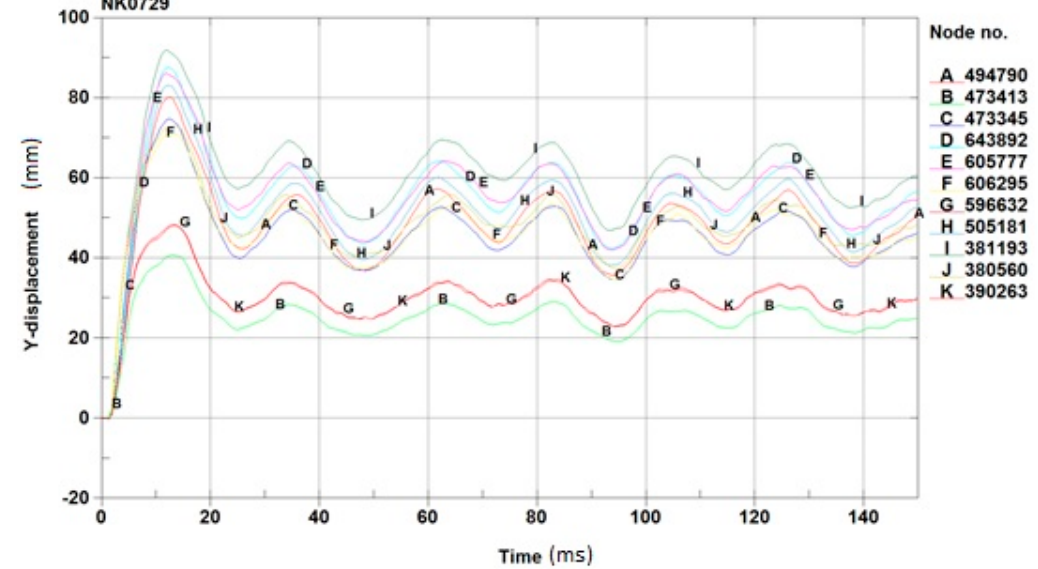
Figure 8. Displacement diagram over time for selected points of the shield for the impact on its center.